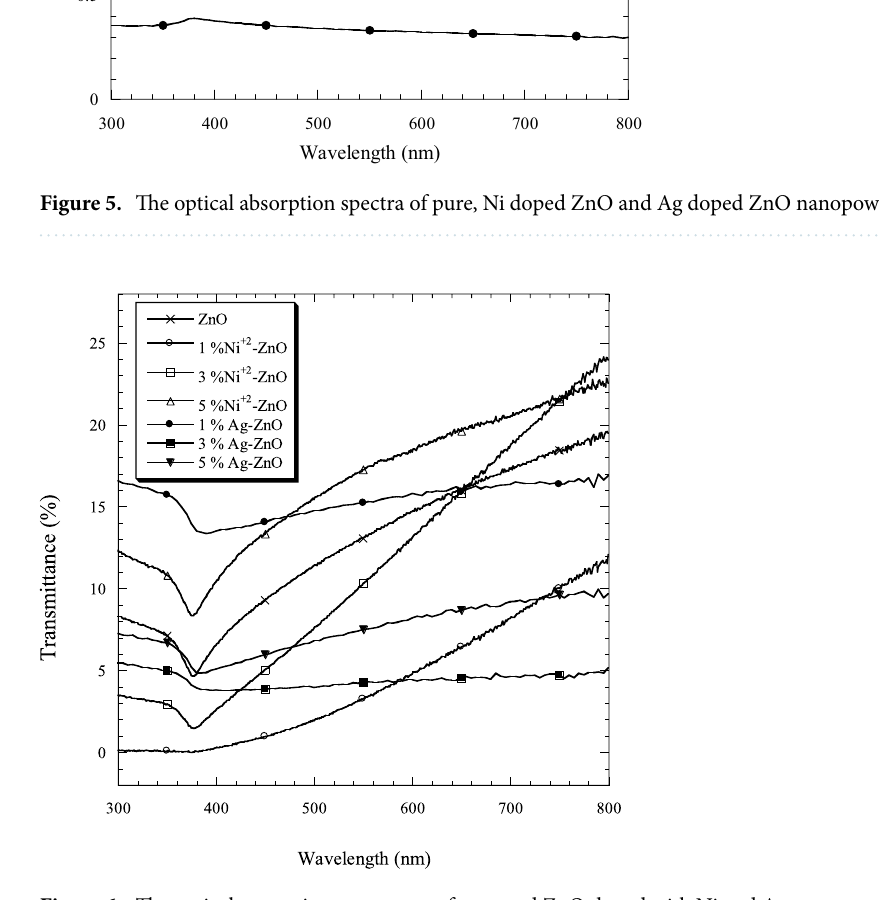
Figure 6. The optical transmittance spectra of pure and ZnO doped with Ni and Ag